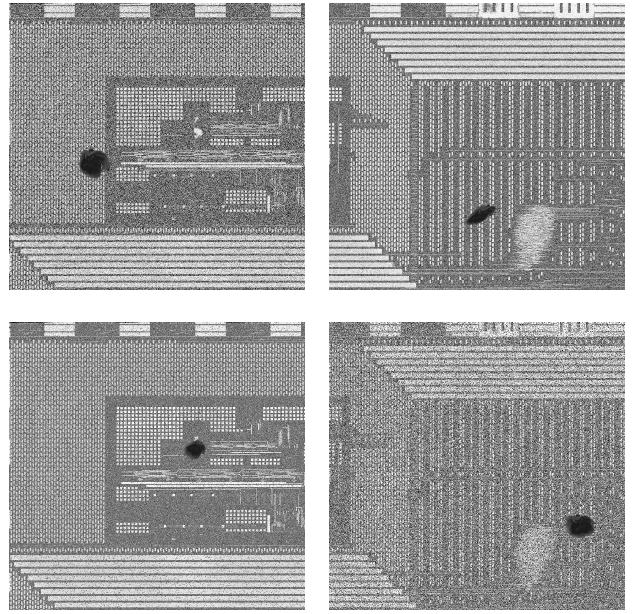
Figure 3. Data samples corrupted by Gaussian noise or salt-and-pepper noise with different intensity and simulated